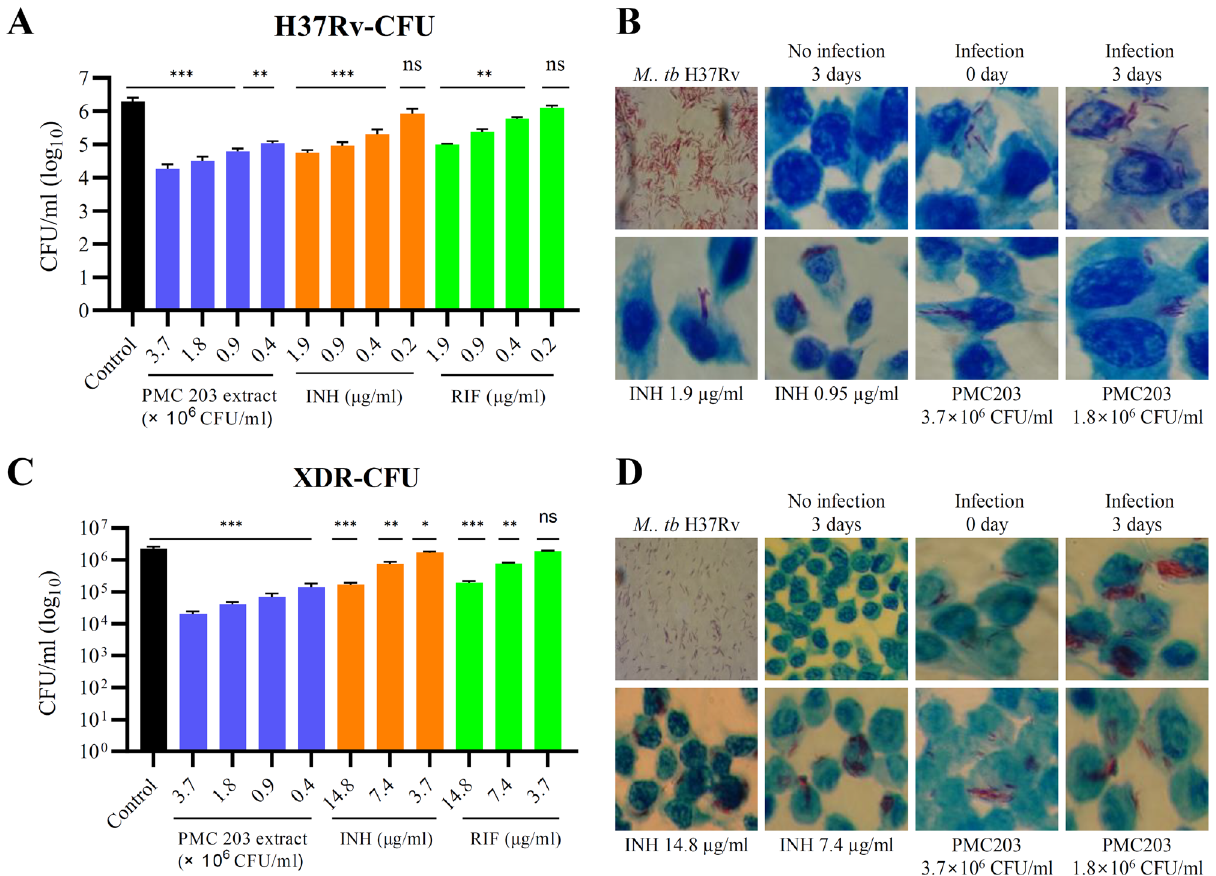
Figure 4. Intracellular killing effect of PMC203 in M. tb infected macrophages. Macrophages were infected with ( A , B ) M. tb H37Rv and ( C , D ), XDR M. tb , treated with PMC203 cell extract along with control drugs, and incubated 3 days. After incubation, viable bacilli were calculated by ( A , C ) CFU enumeration assay and observed by a light microscope after ( B , D ) acid-fast bacilli staining. These experiments were carried out in triplicate. Values are expressed as mean values and standard deviations. *Statistical significance with controls was analyzed using Graph Pad Prism 9.1.1, one-way ANOVA (*p < 0.05, **p < 0.01, ***p < 0.001, ****p < (INH) and rifampicin (RIF), at a wide range of concentrations, and incubated for 3 days. After incubation, the inhibitory effect of the candidate probiotic strain was analyzed by the CFU method (A, C) and AFB staining method (B, D) through comparison with control sample not treated with anything. PMC203 at 4 × 10 5 CFU/ ml to 3.7 × 10 6 CFU/ml significantly reduced the titer of M. tb H37Rv (Fig. 4A). This effect was similar to the reference drugs at 0.4–1.9 µg/ml. The AFB staining result also showed the anti-tuberculosis effect in which the number of H37Rv was increased in the control sample, whereas reduction of H37Rv was observed in samples treated with PMC203 and reference drugs (Fig. 4B). PMC203 also showed an intracellular inhibition activity on XDR M. tb in a macrophage cell line in a dose-dependent manner (Fig. 4C,D). The effect of PMC 203 on XDR M. tb was similar to that on M. tb H37Rv after 3 days of incubation at 4 × 10 5 CFU/ml to 3.7 × 10 6 CFU/ml (Fig. 4C). Reference drugs at 7.4 µg/ml and 14.8 µg/ml showed similar effect to PMC203, but at a 3.7 µg/ml concentration did not show a significant anti-tuberculosis effect. This result indicates that the intracellular activity of PMC203